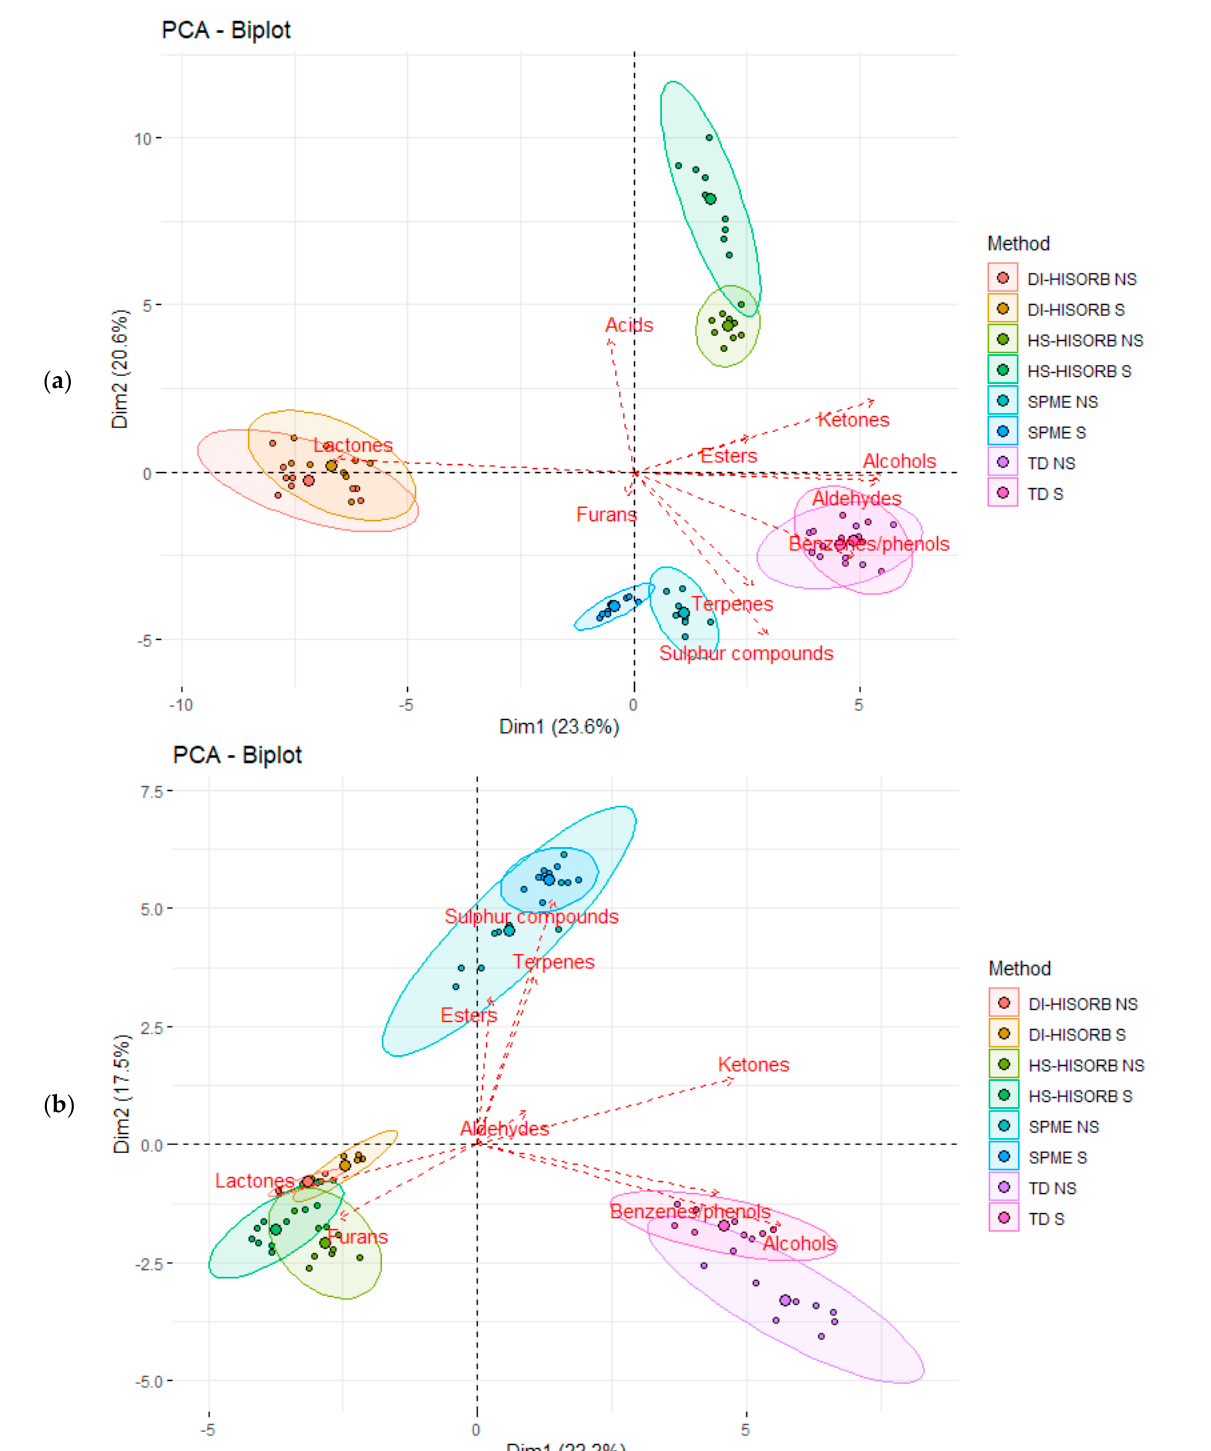
Figure 2. ( a ) Principal component analysis of the volatile organic compounds (as per chemical class) per individual extraction technique, with and without salting out, using the non-polar GC column, and ( b ) principal component analysis of the volatile organic compounds (as per chemical class) per individual extraction technique, with and without salting out, using the polar GC column. Direct Immersion HiSorb without salting out (DI-HiSorb NS), Direct Immersion HiSorb with salting out (DI-HiSorb S), Headspace HiSorb without salting out (HS-HiSorb NS), Headspace HiSorb with salting out (HS-HiSorb S), Thermal Desorption without salting out (TD-NS), Thermal Desorption with salting out (TD S), Headspace Solid Phase Microextraction without salting out (HS-SPME NS), Headspace Solid Phase Microextraction with salting out (HS-SPME S). Figure 2b highlights the same associations of chemical classes with each extraction technique with and without salting out, but using the polar GC column. The level of over- all discrimination was less, at 39.7% (PCA 1 22.2% and PCA 2 17.5%), than that achieved in Figure 2a. As acetic acid was found using the polar GC column, the acid chemical class is not present. Some similar patterns are evident with the polar GC column as found with the non-polar GC column. It is also evident that the impact of salting out was minimal due to the close association of each individual technique with and without salting out (S and NS). For the polar GC column, both DI-HiSorb (DI-HiSorb S and DI-HiSorb NS) and HS-HiSorb (HS-HiSorb S and HS-HiSorb NS) were much more closely associated with lactones and furans. However, there were some anomalies in that DI-HiSorb, independent of salting out, had little or no recovery of furans, and that both DI-HiSorb and HS-HiSorb recovered significant levels of ketones, which were not reflected in the PCA. As previously mentioned, this is due to the use of the percentage of chemical class data rather than indi- vidual VOC data to create the PCA. HS-SPME (HS-SPME S and HS-SPME NS) were most closely associated with sulphur compounds, terpenes, and esters, but also with aldehydes and ketones. TD (TD S and TD NS) were most closely associated with alcohols and ben- zene/phenol VOCs, and, to a lesser extent, with aldehydes and ketones. 3.4. The Selectivity of Each Extraction Technique Figure 3 is a series of Venn diagrams representing the selectivity of each technique in relation to (a) with salting out using the non-polar GC column, (b) without salting out using the non-polar GC column, (c) with salting out using the polar GC column, and (d)